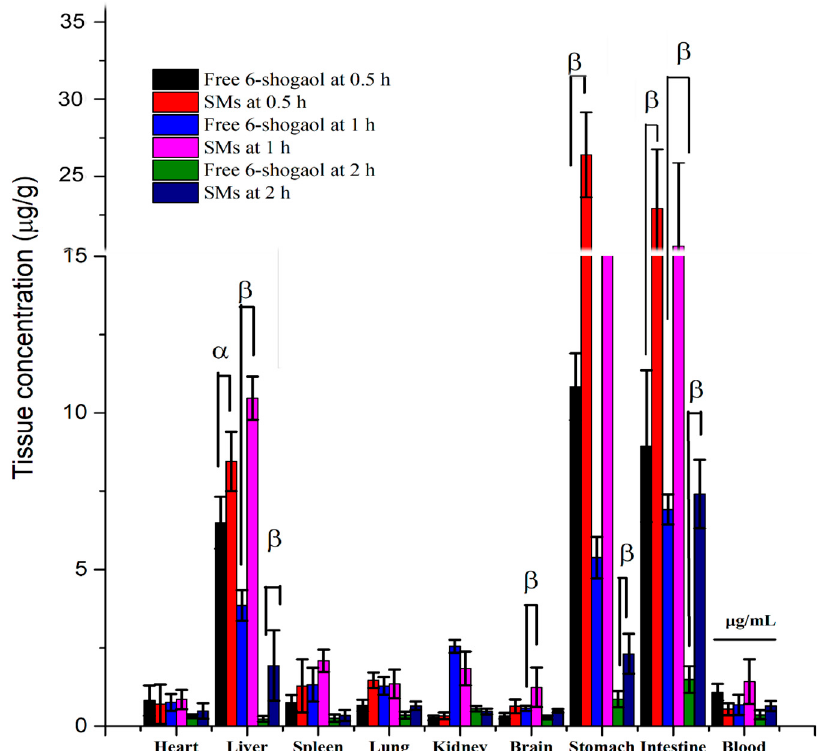
Figure 5. Concentration of 6 ‐ shogaol in the heart, liver, spleen, lung, kidney, stomach, small intestine brain and blood following oral administration of a single 100 mg/kg dose of free 6 ‐ shogaol and SMs to mice at 0.5 h, 1 h and 2 h point. Results are presented as the Mean ± SD (n = 5). α P < 0.05 SMs versus free 6 ‐ shogaol. β P < 0.01 SMs versus free 6 ‐ shogaol.